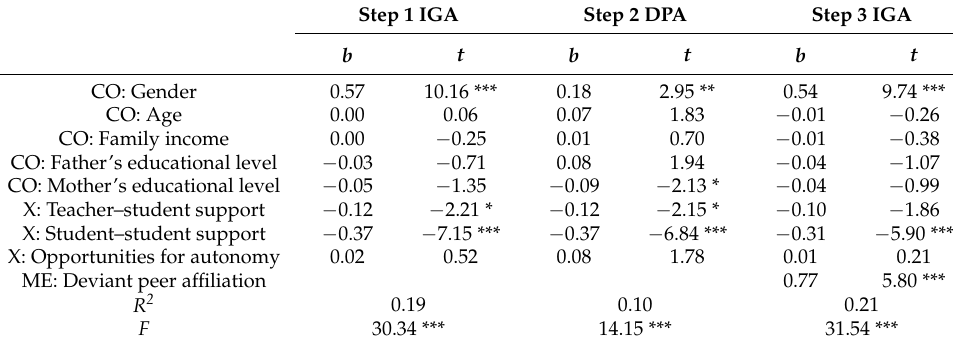
Table 2. Testing the mediation effect of perceptions of school climate on online gaming addiction ( N = 1053). Step 1 IGA Step 2 DPA Step 3 IGA b t b t